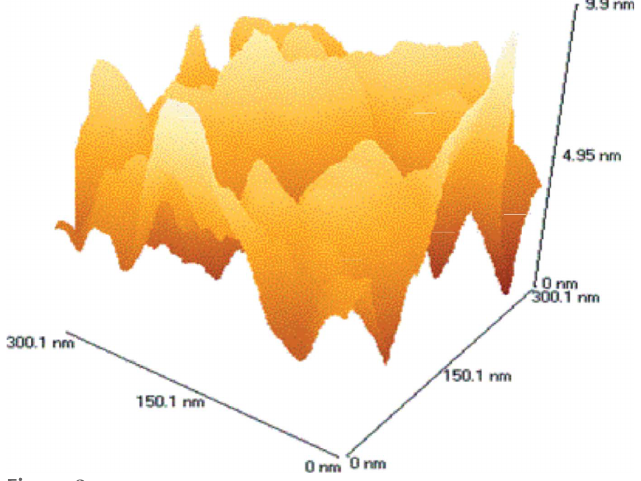
Figure 3 An image of the rough sample obtained with an atomic force